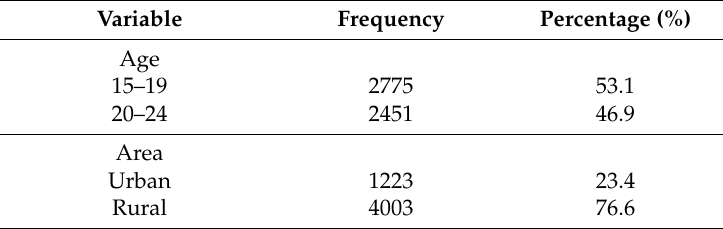
Table 1. Baseline characteristics of the study population, Nepal Multiple Indicator Cluster Survey (MICS)